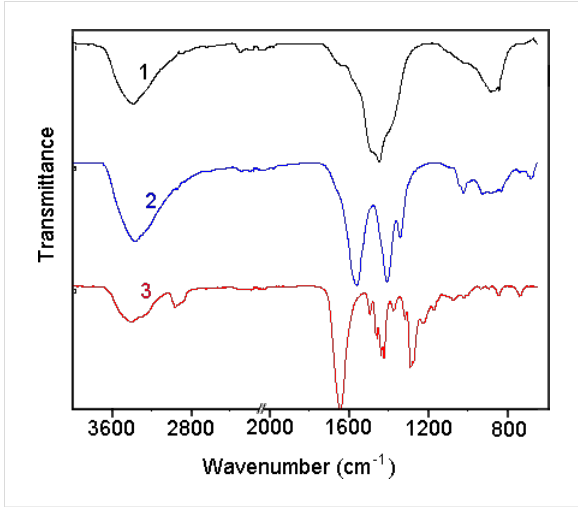
The presence of various chemical functional groups in PVP ( M S = 10,000) is indicated by FTIR spectra as shown in Figure 5 (curve 3). The broad absorption band at 3399.6 cm − 1 is due to O–H stretching vibrations of adsorbed water at the surface of particles. A peak at 1645 cm − 1 is assigned to the stretching vibration of the C=O. The absorption peak at 1373.6 cm − 1 is due to the С – Н bond in PVP [21]. Other impor- tant peaks at 1287.6 cm − 1 and the doublet at 1437.8 cm − 1 , 1422.4 cm − 1 are assigned to the C–N stretching vibrations and the attachment of CH 2 groups in the pyrrole ring of